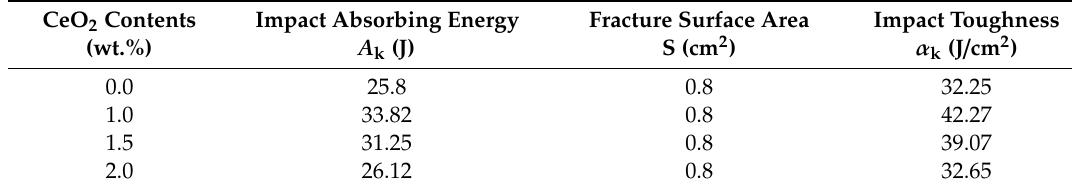
Table 3. Impact test data of di ff erent coatings.